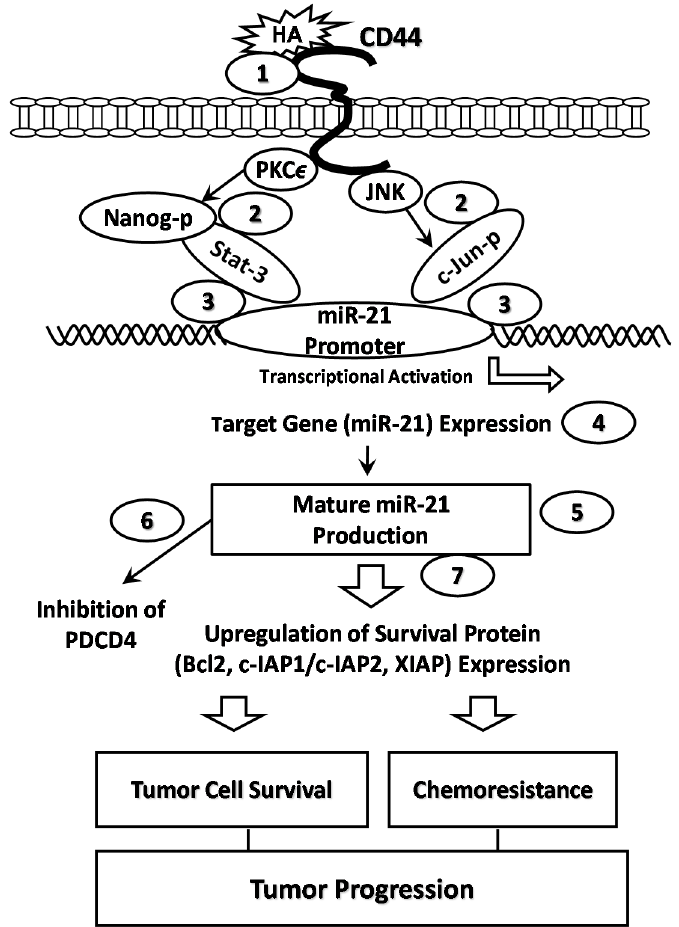
Figure 3. PKC ϵ and JNK (c-Jun-NH2-Kinase) Signaling Pathways in Regulating